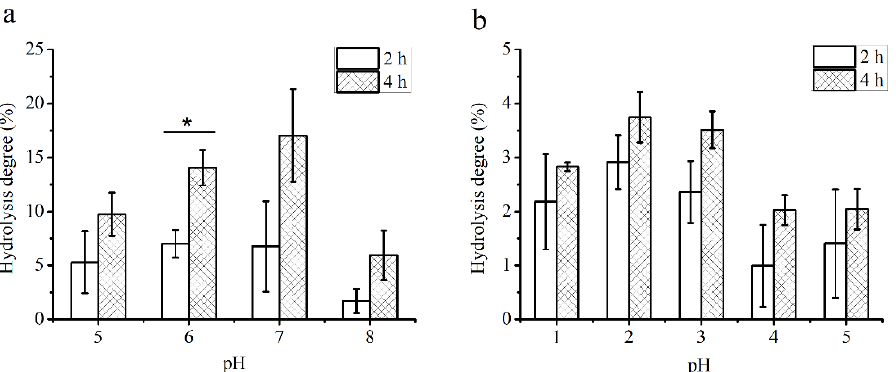
Figure 1. Hydrolysis degree of PS in artificial human saliva ( a ) and in a simulated gastric acid ( b ). * Indicates that there is a significant difference between treated times ( p < 0.05).